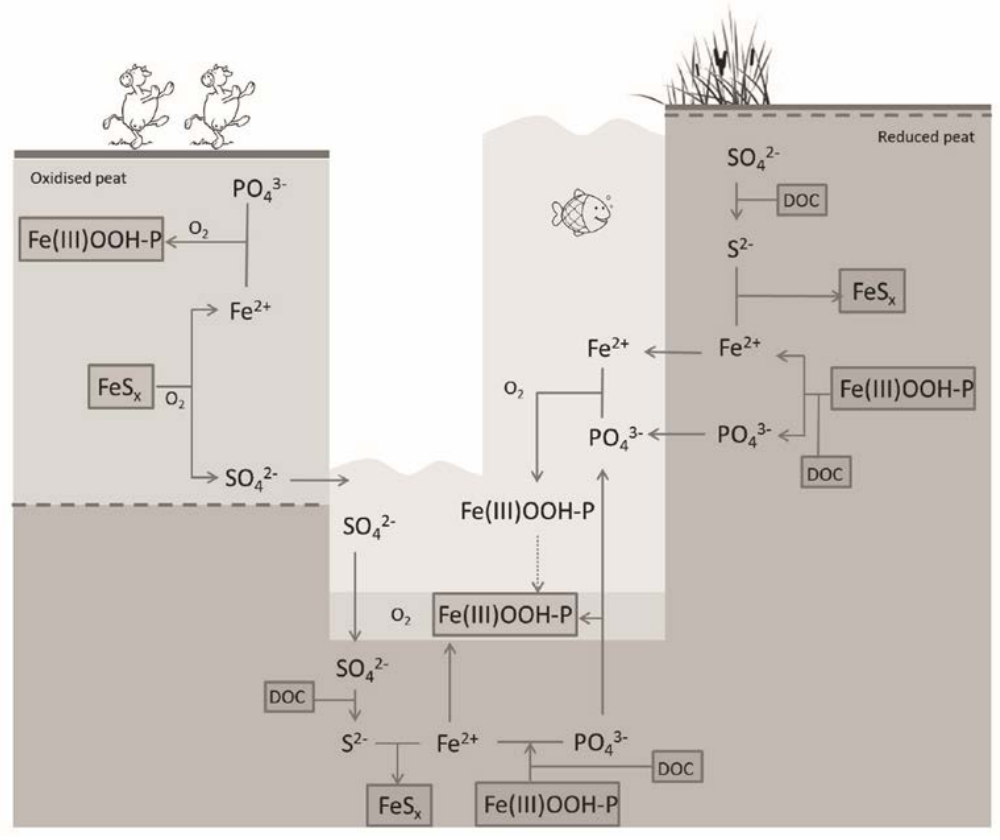
Figure 2. Schematic overview of interactions between P, Fe and S cycling for drained (left panel; low water tables) and rewetted (right panel; high water tables) coastal peatlands, and the resulting effects for adjacent surface water. See text for further explanation (from: van Diggelen